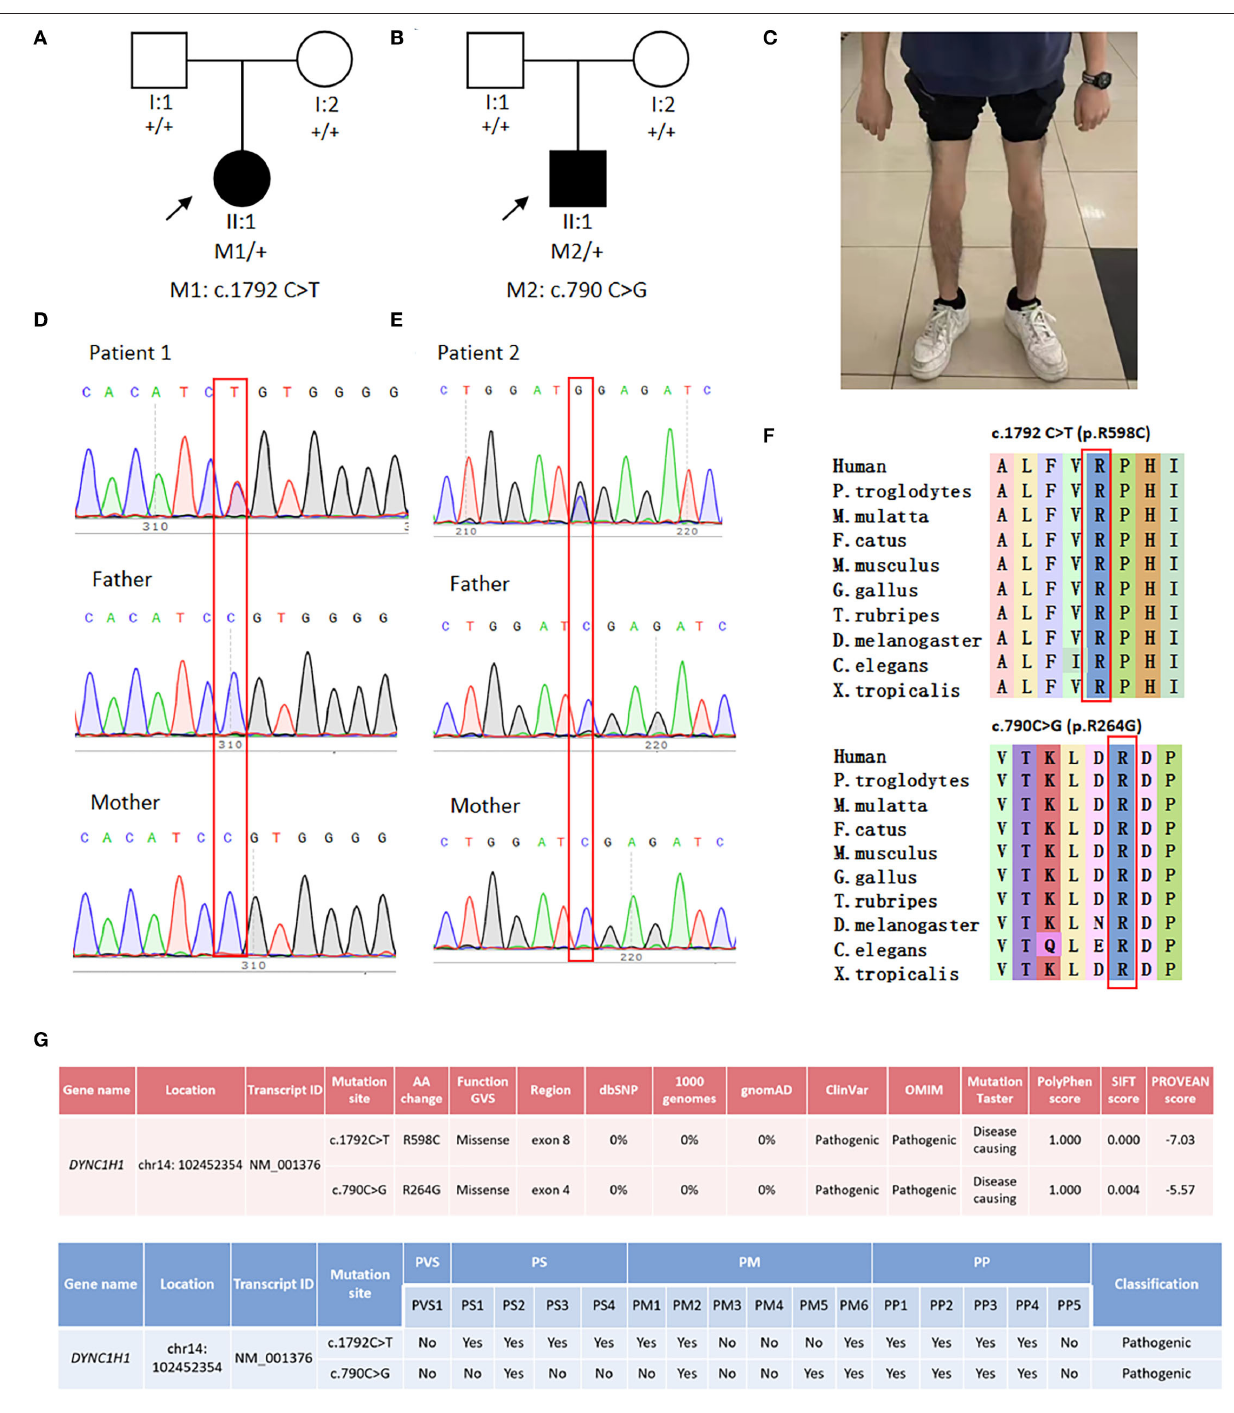
Frontiers in Neurology |